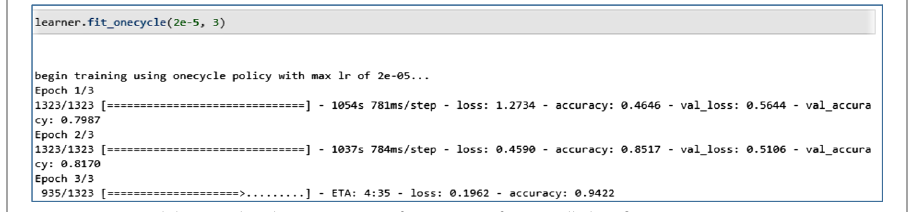
Fig. 21 Bert model created with an accuracy of 94 percent for overall classification (Macro)